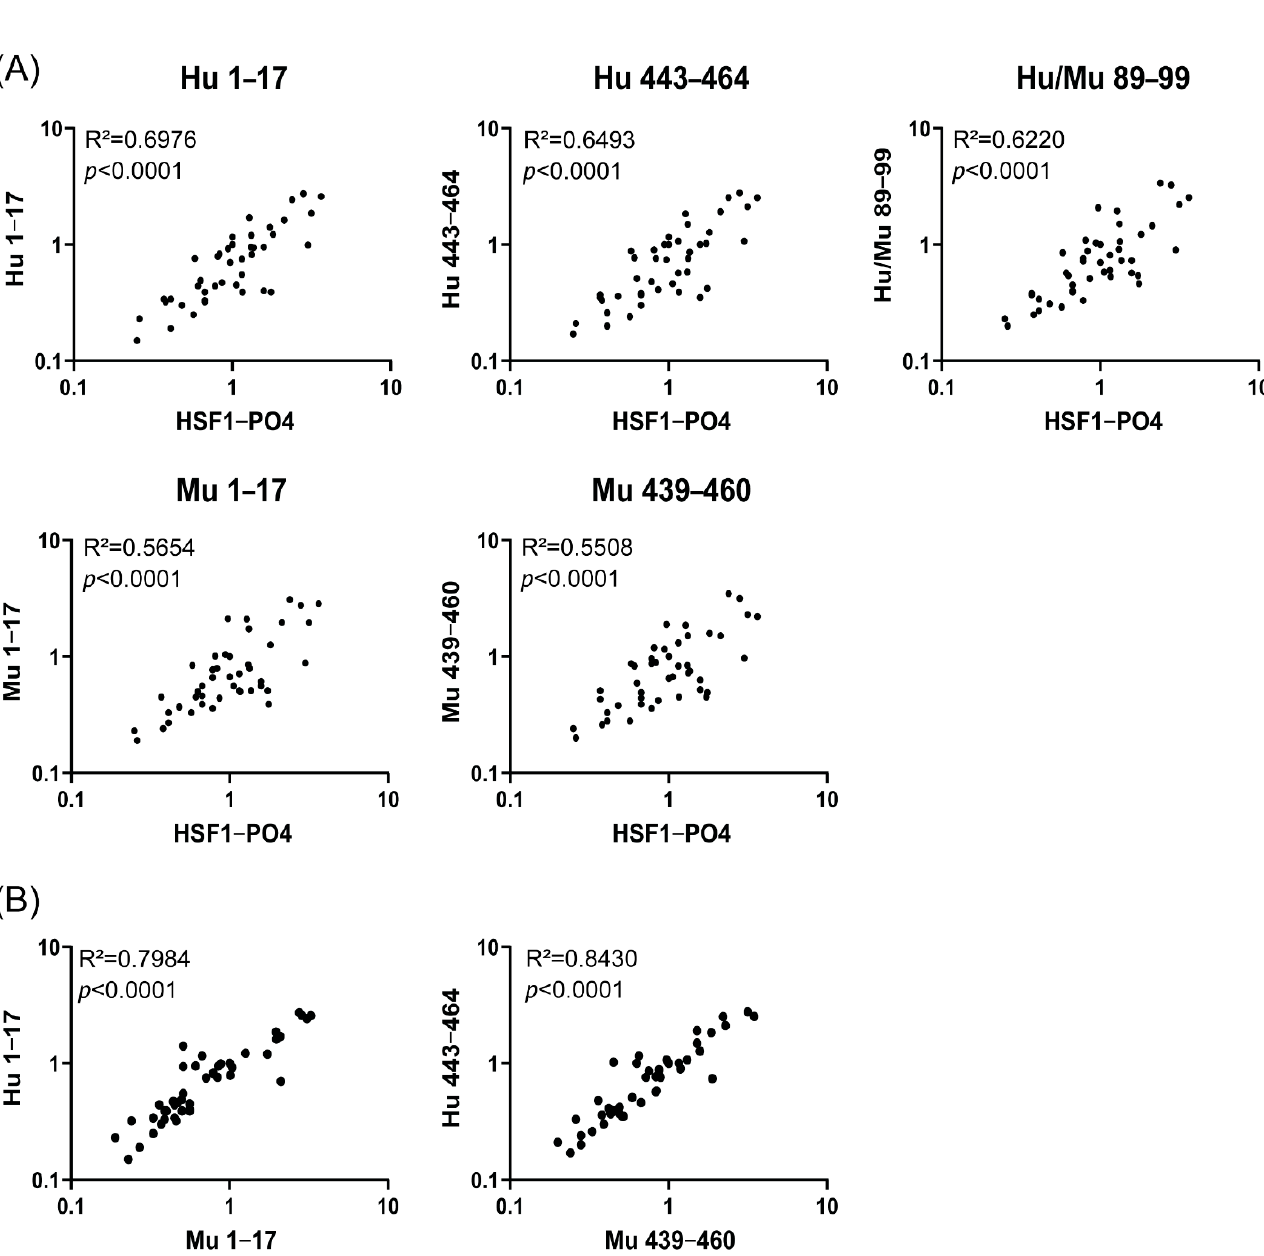
Figure 4. IgA antibody responses to anti-HSF1-PO4 and predicted epitopes in cohort 2 patients ( n = 45). Responses in sera (diluted 1:10) from patients with no pathology ( n = 11), benign serous cystadenoma ( n = 9) and late stage HGSOC (total n = 25, diagnosis/pre-surgery = 16, pre-cycle 1 = 6, pre-cycle 2 = 3) were measured via indirect ELISA and normalised to a mid-responder (OV0023). OD 450nm for mid-range responder as follows: HSF1-PO4 (0.41 or 0.69); Hu 1–17 (0.95); Hu 443–464 (1.0); Hu/Mu 89–99 (0.54 or 0.58); Mu 1–17 (0.52 or 0.62); Mu 439–460 (0.51 or 0.68). ( A ) Pearson’s R correlation (R 2 ) and p -value of normalised peptide responses to HSF1-PO4 responses plotted on a log scale. ( B ) R 2 and p -value of normalised responses of corresponding human and mouse sequences, plotted on a log scale. R 2 shown for Mu 1–17, although dataset did not pass normality test (Supplementary Table S2).